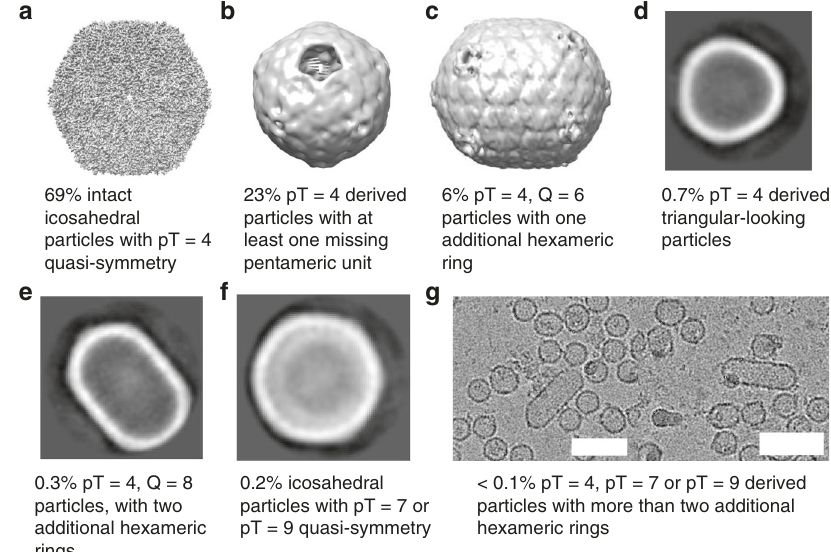
Fig. 5 Cryo-EM classes of BDP subtypes. a 3D class at 3.3 Å resolution and atomic model of whole intact pT = 4 quasi-symmetric icosahedral particles, in total 69%. b 8.8 Å resolution 3D class of pT = 4 derived particles, with at least one missing pentameric unit, in total 23%. c 9.6 Å resolution 3D class of pT = 4, Q = 6 quasi-symmetric particles, in total 6%. d 2D class of triangular-looking particles, judging from the size probably derived from three fused pT = 4 particles, in total 0.7%. e 2D class of pT = 4, Q = 8 particles, in total 0.3%. f 2D class of pT = 7 or pT = 9 quasi-icosahedral particles, in total 0.2%. g Separate micrographs of tubular particles elongated with more than two hexameric rings, in total less than 0.1%. Scale bar: 60